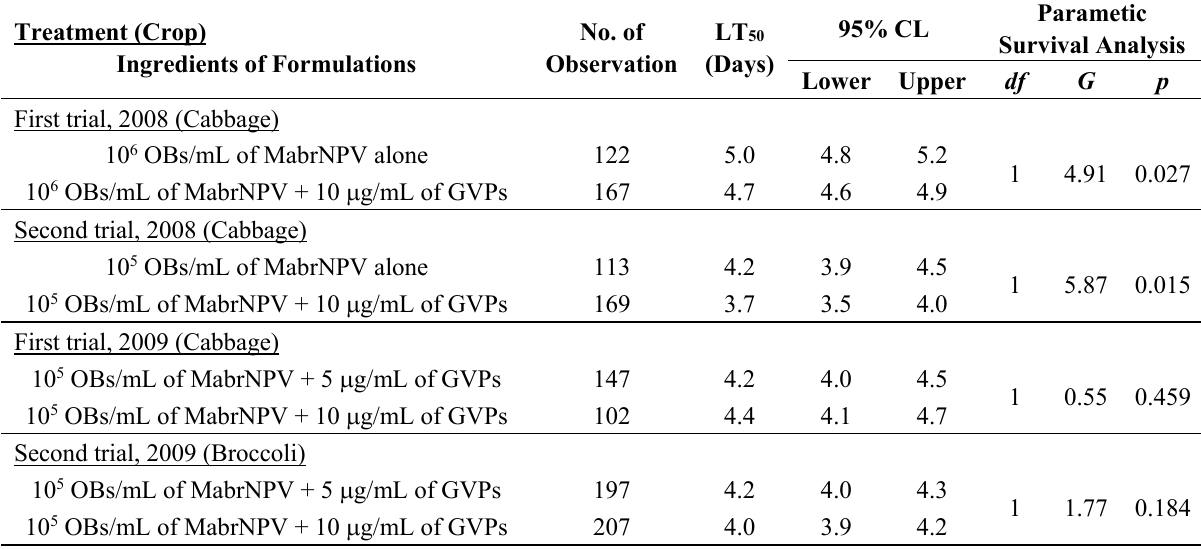
Table 4. Median lethal times of Mamestra brassicae larvae collected from field plots treated with